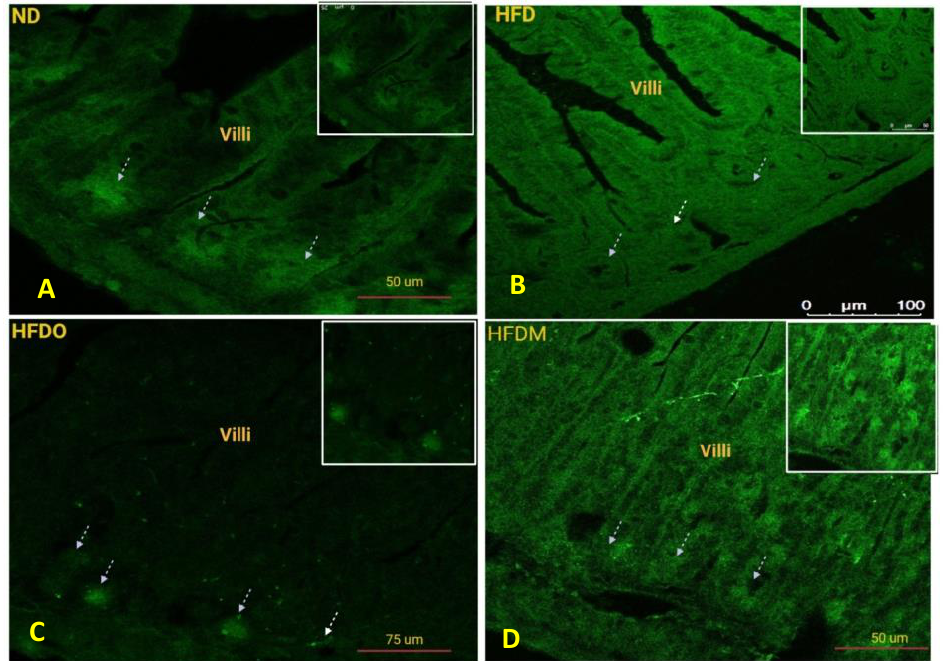
Figure 17. The impact of high-fat diet treatment on Nesfatin-1/NUCB-2 expression in mouse jejunum using immunofluorescence. HFD-fed mice showed lower expression of satiety molecule Nesfatin-1 in the mouse jejunum (arrows). Treatment with MESK and Orlistat increased the expression of Nesfatin-1 (arrows). ( A ) ND: normal diet, ( B ) HFD: high-fat diet, ( C ) HFDO: HFD + Orlistat, and ( D ) HFDM: HFD + MESK.